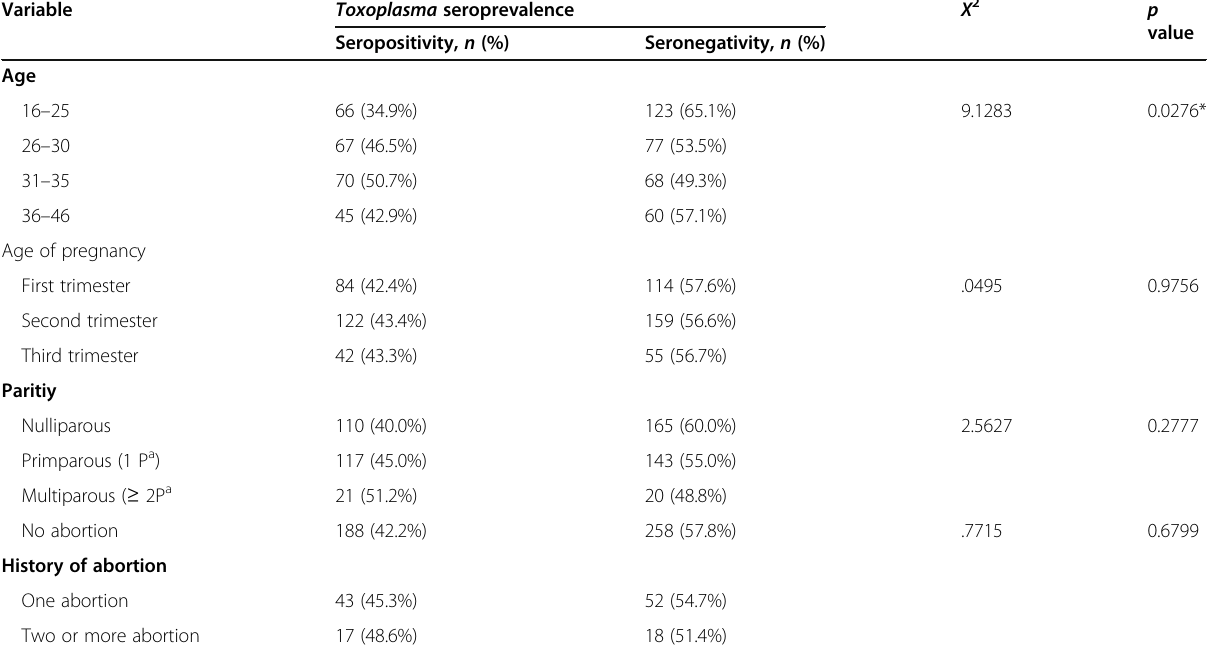
Table 3 Seroprevalence of toxoplasmosis according to age, parity, and history of abortion among pregnant women in Rabat region